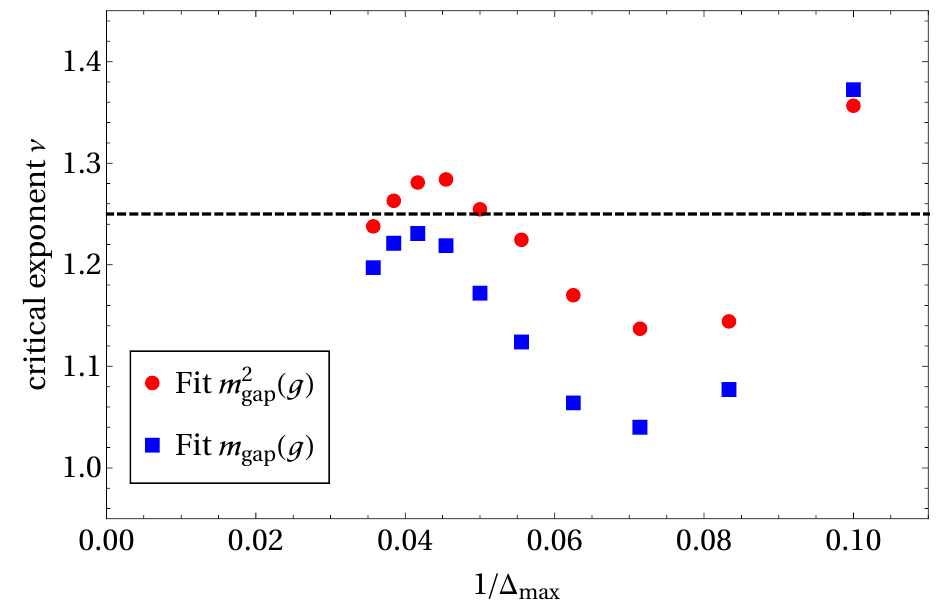
Figure 6 . The numerical fit to the critical exponent ν of the SUSY Yukawa theory near the critical coupling. The theoretical expectation (black dashed line) from TIM is ν = 5 values (red dots) oscillate around the theoretical prediction and approch it as ∆ max increases. The blue squares are the critical exponents extracted from the same data using the same procedure but fitting to m gap instead of m 2 gap